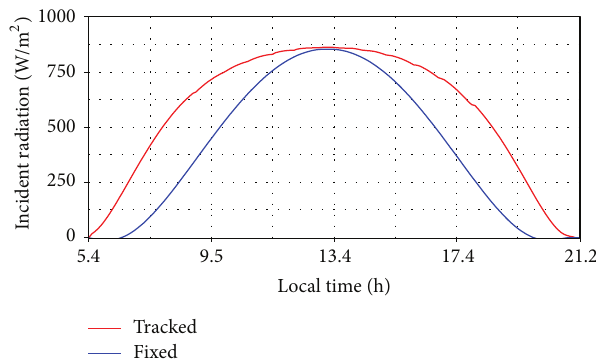
Figure 12: The incident radiation curves (with and without track- ing).